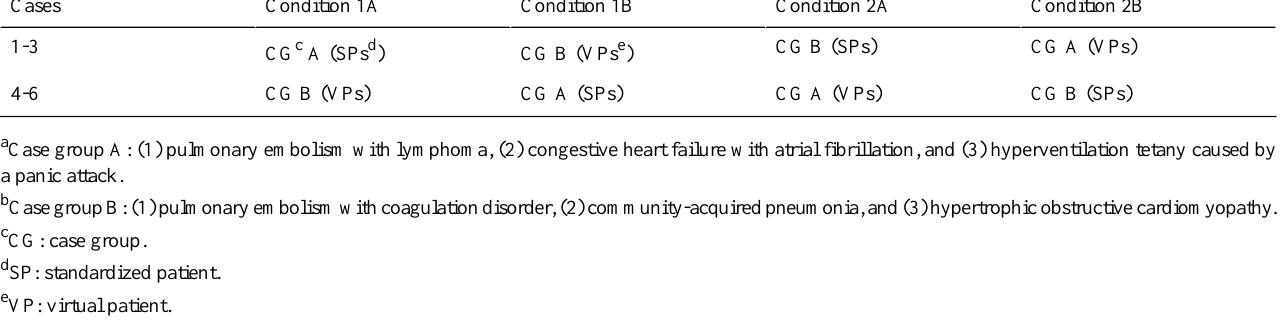
Condition 2BCondition 2ACondition 1BCondition